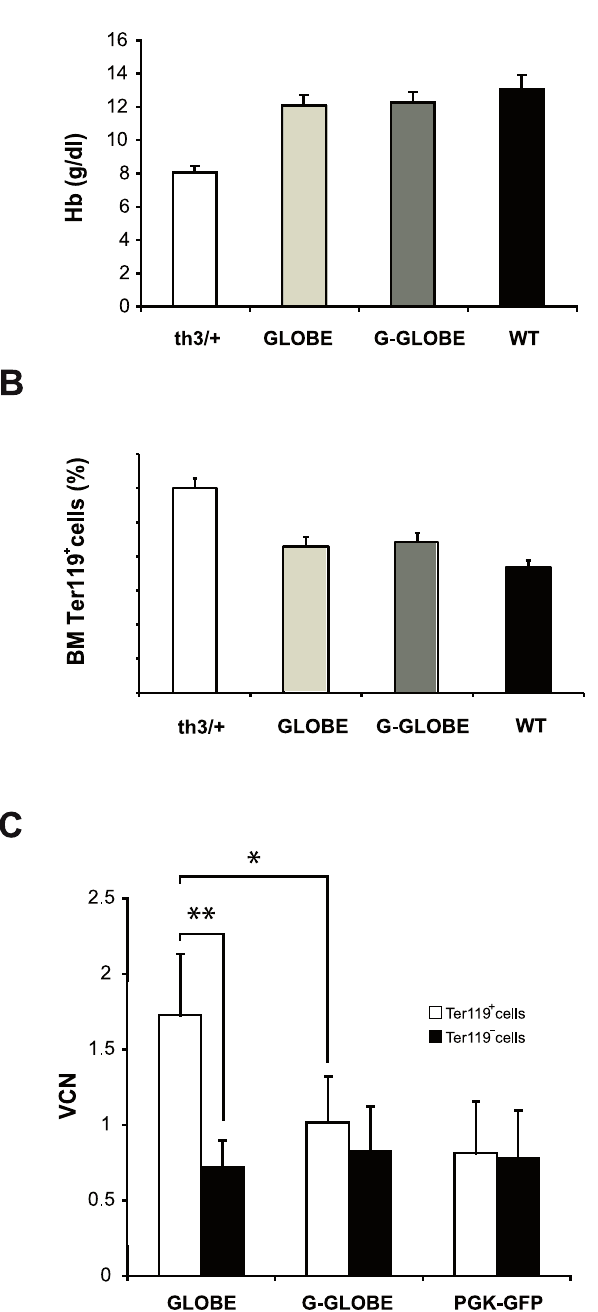
Figure 4. A low G-GLOBE vector copy number is sufficient to correct of the murine thalassemic phenotype. (A) Hb concentra- tion in peripheral blood of mice transplanted with mock-transduced th3/ + (white column; n=8), normal (WT; black column; n=9) and GLOBE- (GLOBE; light gray column; n=8) and G-GLOBE (G-GLOBE; dark gray column; n=8) transduced BM th3/ + cells. Values represent the mean and SEM for each group of animals. Hb levels were not significantly different in th3/ + mice transplanted with GLOBE- and G- GLOBE-transduced HSCs. (B) Percentages of Ter119 + cells in BM of mice transplanted with mock-transduced th3/ + (white column; n=8), normal (WT; black column; n=9) and GLOBE- (GLOBE; light gray column; n=8) and G-GLOBE (G-GLOBE; dark gray column; n=8) transduced BM th3/ + cells. Values represent the mean and SEM for each group of